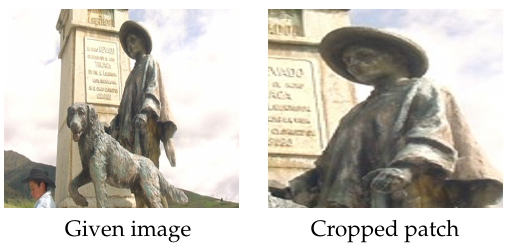
Figure 7. Data augmentation by cropping. Left and right: the given image (from ImageNet) labelled as “Dog” and the cropped patch. It is clear that the “Dog” is no longer visible in the cropped patch. Rotation. Rotation is a simple geometric data augmentation technique. The images are rotated by a specified angle, and the newly created images are used alongside the